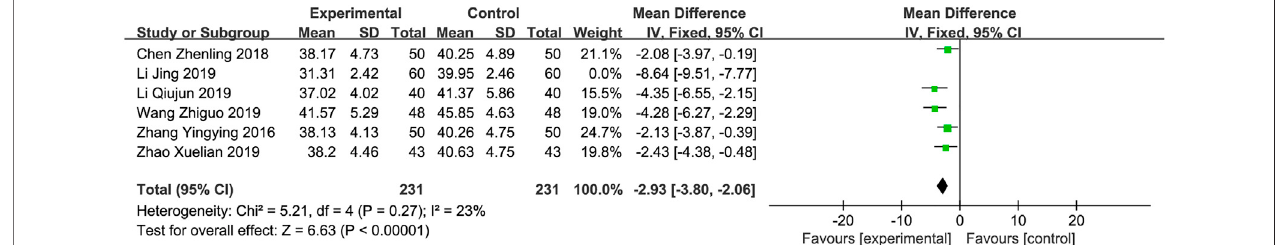
FIGURE 5 | Forest plot of LVESD.